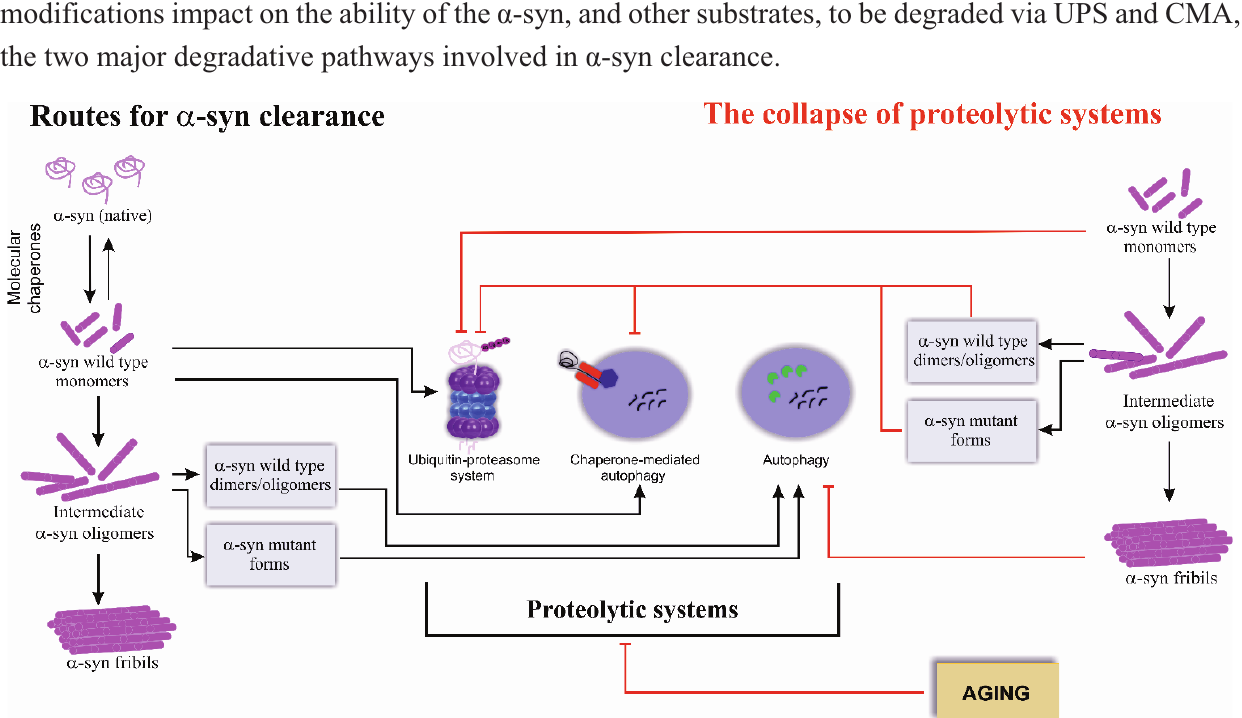
Figure 1. The routes for (cid:2)-synuclein ((cid:2)-syn) clearance. (cid:2)-Syn exists as a soluble monomer that can undergo misfolding into toxic species, dimers and intermediate oligomers, which can further form superfibriliar aggregates. The clearance of different (cid:2)-syn species occurs via two main proteolytic systems, ubiquitin-proteasome system (UPS) and the lysosome-mediated degradation (particularly chaperone-mediated autophagy (CMA) and macroautophagy (referred as autophagy)). UPS and CMA are the main degradation routes of soluble wild type (cid:2)-syn, while autophagy is the preferred clearance pathway for intermediate oligomers or mutant (cid:2)-syn forms. (cid:2)-Syn levels, mutations and post-translational modifications, impact on the proteolytic systems function leading to their collapse. Aging is also a factor associated with the impairment of the proteolytic systems function, which predispose the cells to the accumulation of (cid:2)-syn toxic species. See the text for